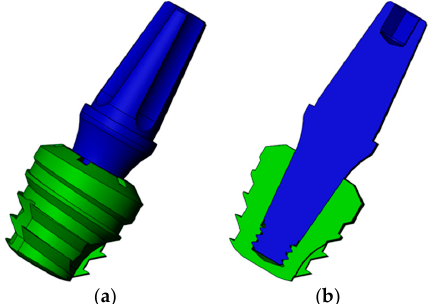
Figure 2. Three-dimensional model of Morse taper (MT) extra-short implants: ( a ) Implant in green and abutment in blue; ( b ) transversal cut of the model.